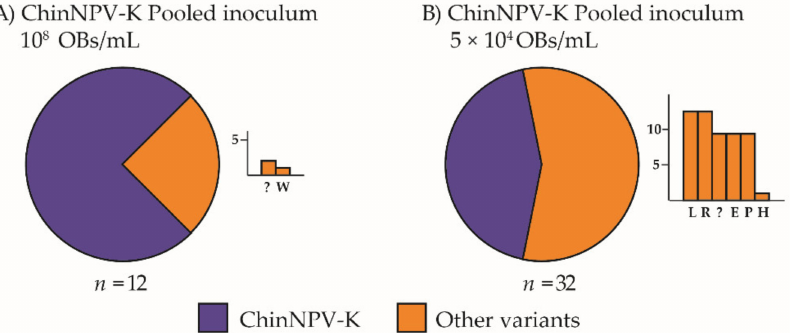
Figure 5. Prevalence of REN profiles in Chrysodeixis includens fifth instar larvae that died following inoculation with ( A ) 10 8 OBs/mL or ( B ) 5 × 10 4 OBs/mL of a pooled OB inoculum derived from insects that had been originally inoculated with ChinNPV-K variant OBs. Circular charts represent the proportion of REN profiles of ChinNPV-K and other variants recovered from dead larvae. A bar chart is depicted next to each circular chart specifying which REN profiles were recovered among the other variant profiles and their frequency. The y -axis indicates the number of insects that showed a particular dominant REN profile in the progeny OBs and the x -axis indicates each of the REN profiles observed in descending frequency; n indicates the number of insects analyzed. Novel REN profiles were classified as unknown and are shown as “?” in bar